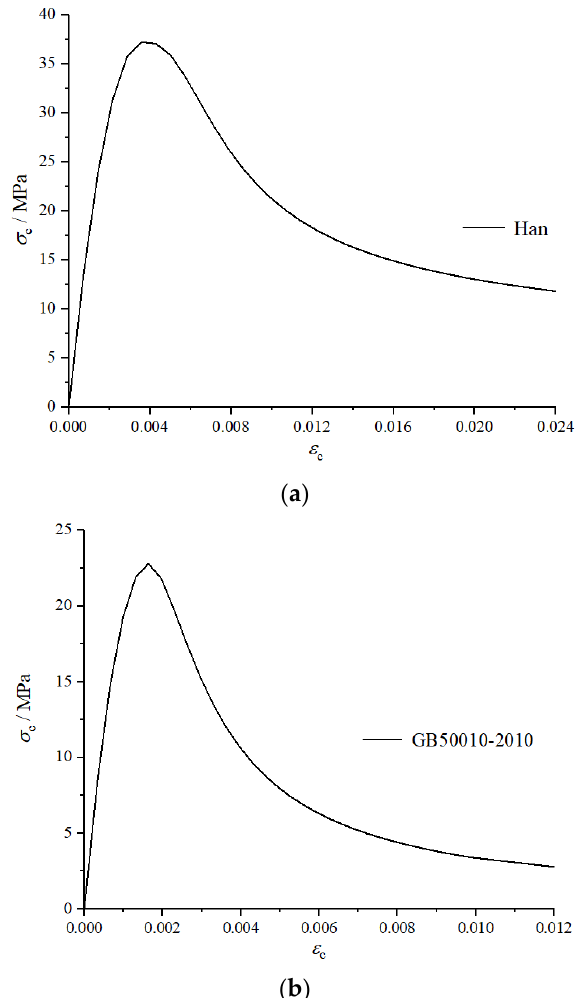
Figure 8. Stress–strain curves: ( a ) stress–strain relation model used for in-filled concrete in the square steel tube; ( b ) stress–strain relation model used for the normal concrete of the composite beam.